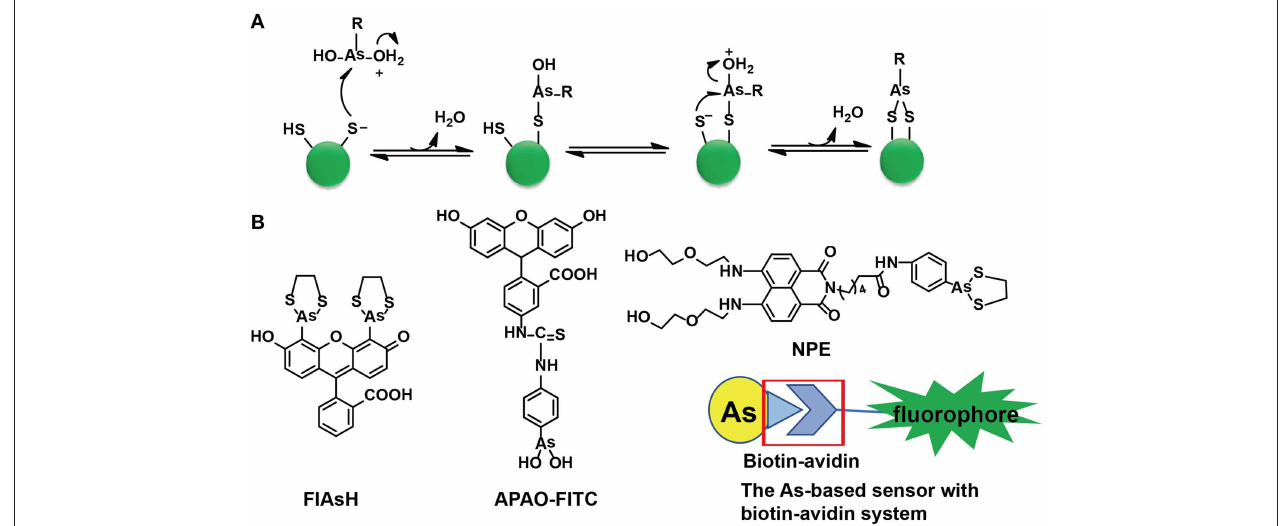
FIGURE 1 | The As(III)-based thiol-reactive fluorescent probes. (A) The recognition mechanism of As(III) binding toward two closely spaced cysteines. The buffer action can make several RAs(OH) 2 molecules to be protonated at the hydroxyl oxygen (R stands for any other chemical group). The attack of a thiolate anion on As(III) can release a water molecule. Then a proton transfer between the other thiolate anion and the hydroxyl oxygen is induced by the buffer action whilst the attack of this thiolate anion on As(III) will proceed an intramolecular displacement of another water molecule. (B) The structures of typical As(III)-based probes designed by different strategies. (A) was adapted from Gasser (2014) Copyright 2014